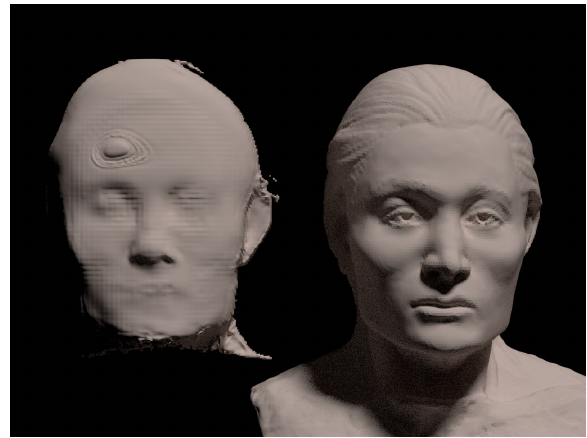
Figure 7. Face approximation by skull2face neural network model (left) and artistic manual clay reconstruction on fossil skull